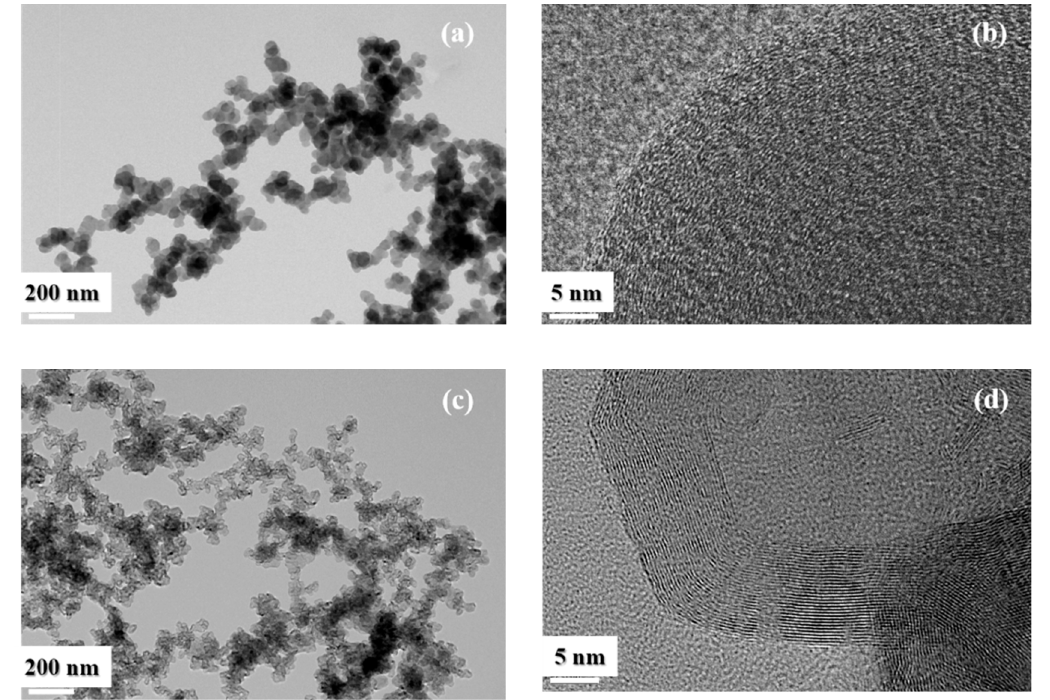
Figure 2. TEM images of ( a ) as-obtained soot, ( c ) annealed soot. ( b ) and ( d ) are the corresponding HR-TEM images.